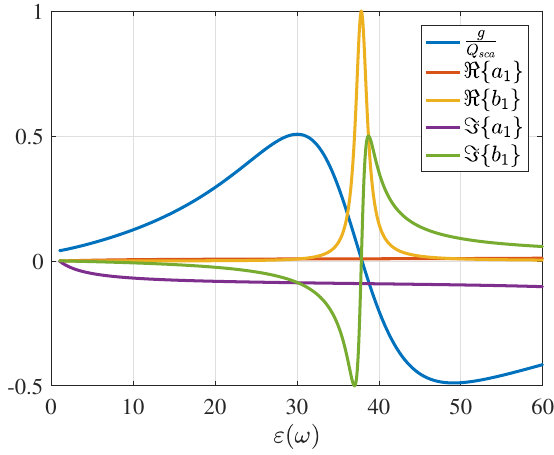
Figure 9. The normalized asymmetry factor for the case of a lossless sphere of size x = 0.5. = 30.06 and the minimum valley (maximum The maximum peak (forward scattering) occurs at ε Mie F = backscattering) at ε Mie B